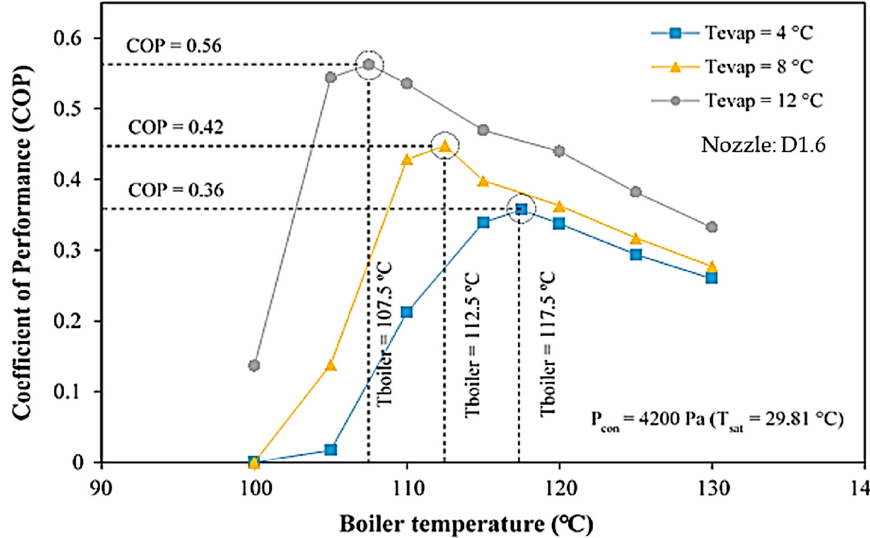
Figure 5. The system COP influenced by the evaporator.